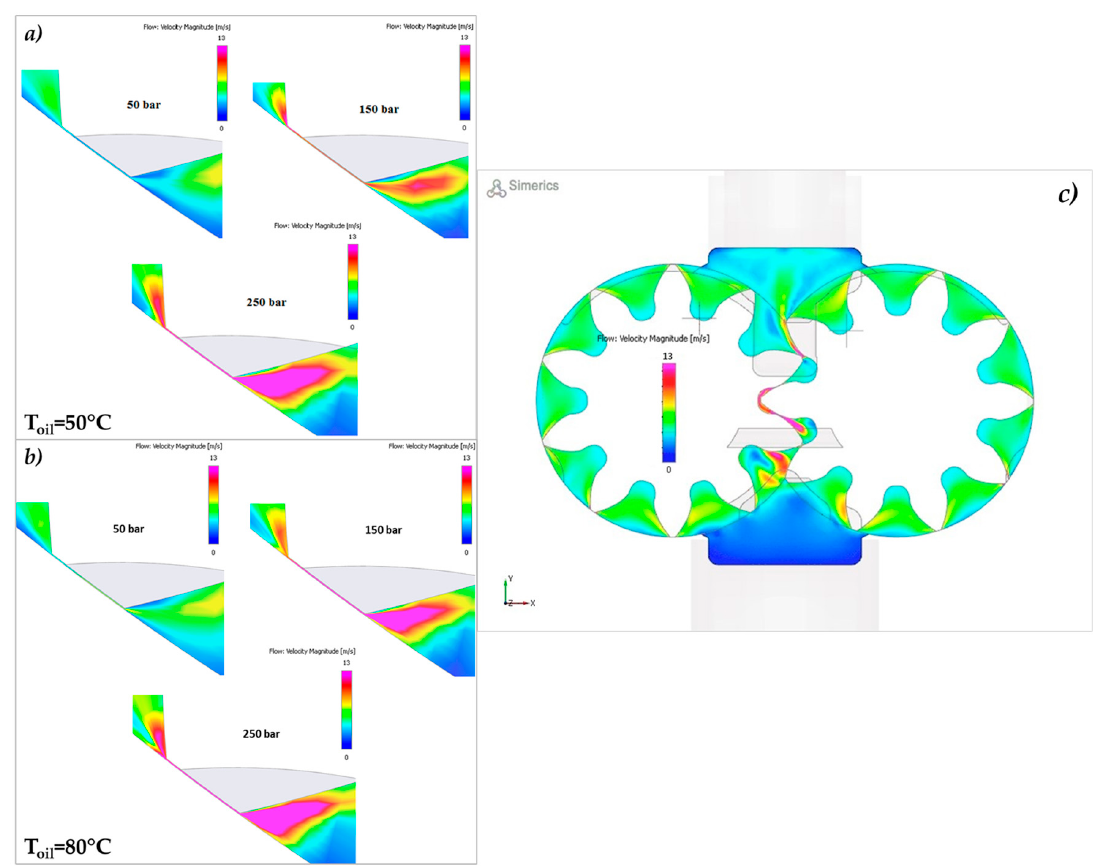
Figure 14. Velocity magnitude at ( a ) 50 °C, ( b ) 80 °C and ( c ) zoomed area.